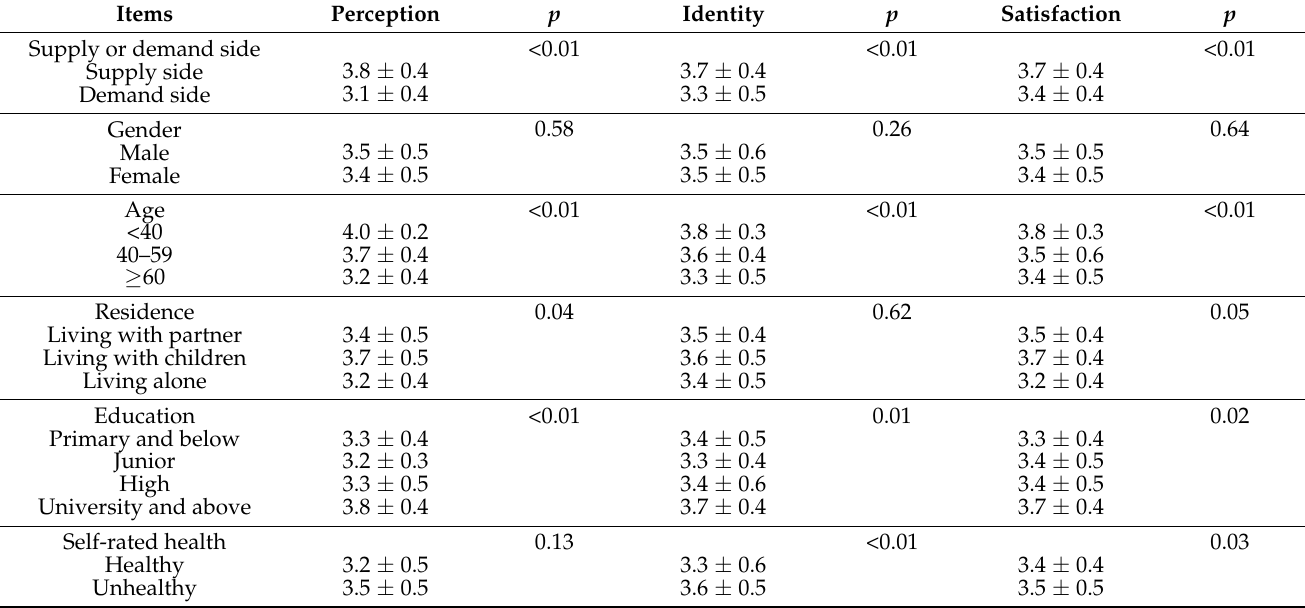
Table 2. Univariate analysis of perception, identity, and satisfaction.